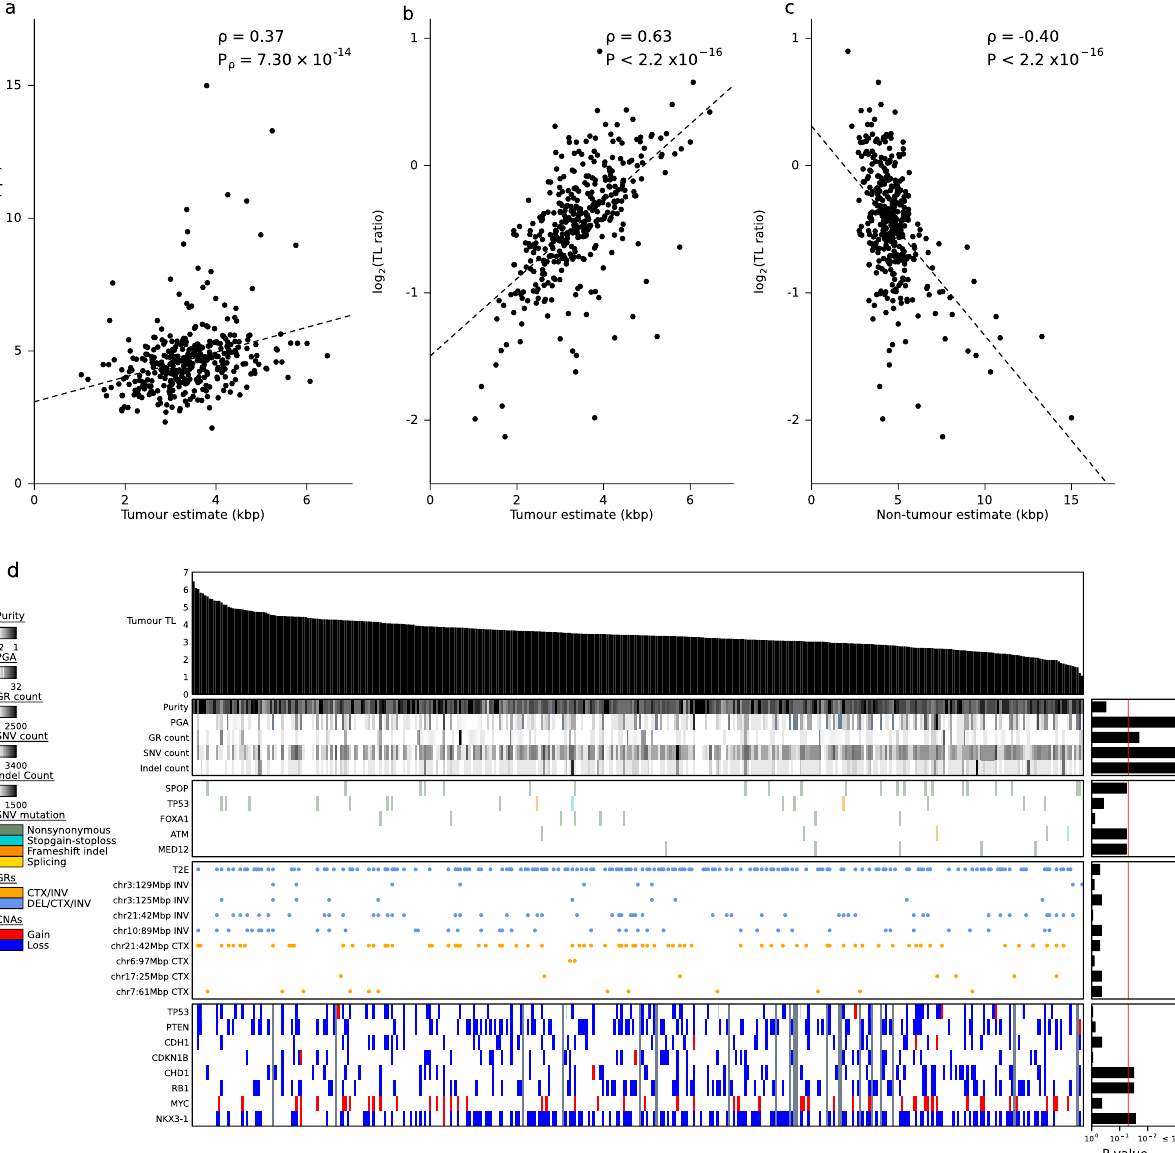
Fig. 1 Tumour telomere length (TL) is associated with genomic features. a Spearman correlation between tumour TL and non-tumour TL. b Spearman correlation between tumour TL and TL ratio (tumour TL / non-tumour TL). c Spearman correlation between non-tumour TL and TL ratio. d Tumour TL is ranked in descending order of length (kbp). The association of tumour TL and measures of mutational burden (PGA; percent genome altered), TMPRSS2:ERG (T2E) fusion status, as well as known prostate cancer genes with recurrent copy number aberrations (CNAs), coding single-nucleotide variants (SNVs), indels (insertion and/or deletion) and genomic rearrangements (GRs) are shown. Bar plots indicate the statistical signi fi cance of each association